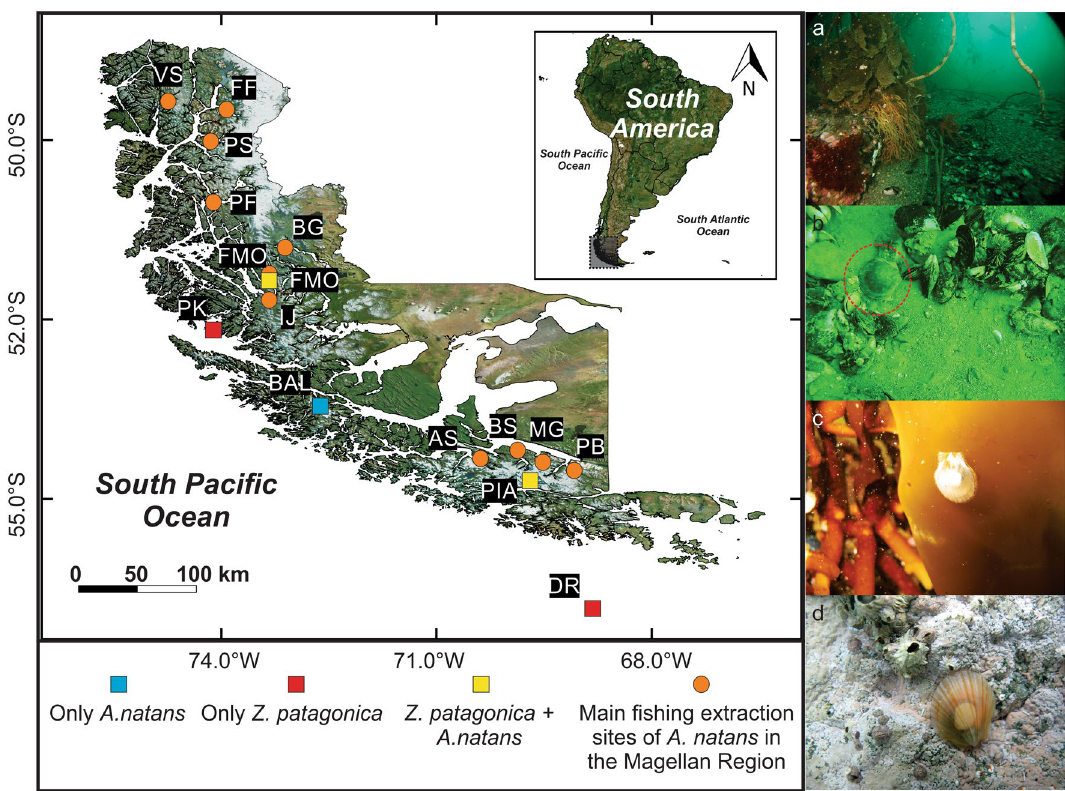
Figure 1. Sampling locations in the Magallanes Region in squares. From north to south: FMO: Montaña Fjord; PK: Parker Island; BAL: Ballena Fjord; PIA: Pia Fjord-Beagle Channel and DR: Diego Ramirez Archipelago. Main fishing extraction sites of A. natans in the Magellanic in orange circles. From north to south (extracted from Comité Científico Bentonico 2018): VS: Ventisquero Sound; FF: Falcon Fjord; PS: Penguin Sound; PF: Peel Fjord; BG: Balmaceda Glacier; FMO: Montaña Fjord; IJ: Jaime Island; BAL: Ballena Fjord; AS: Agostini Sound; BS: Brook Sound; MG: Marinelli; PB: Parry Bay. Columns of photographs show different habitats of collected samples: ( a ) typical habitat of specimen collected in this study, ( b ) Adult scallop on muddy bottom in FMO, ( c ) Juvenile scallop attached to a kelp ( d ) Juvenile scallop on calcareous algae bottom. The map was created in QGIS software ver. 3.16 46 available in: https:// qgis. org/ en/ site/. Credits to photographs Jaime Ojeda